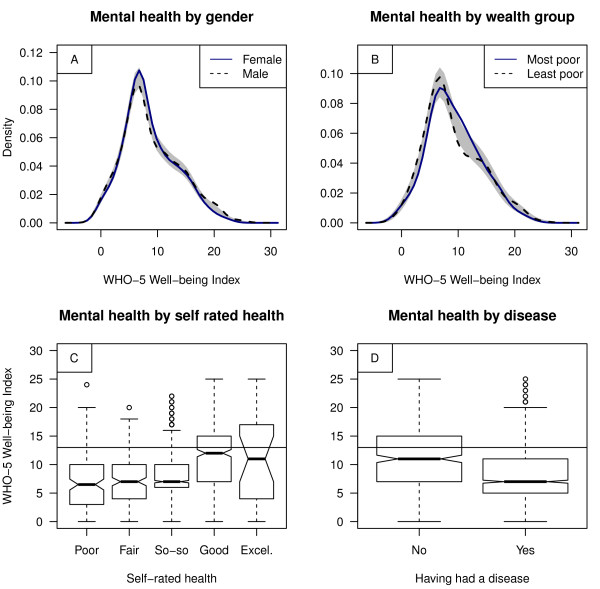
Descriptive statistics for WHO-5 scores (mental well-being), self-rated health and diseases. For A and B, a bootstrap hypothesis test of equality between the both groups was applied with gender being equal (p value = 0.55) and wealth group being significantly different from each other (p value = 0.04), indicated by a reference band in grey. For B, least poor implies to the upper wealth index quintile, while most poor implies to the lowest. Note that for C and D, a WHO-5 scored 13 or above has been found to be indicative of good mental well-being in high-income country settings (cf. horizontal line).